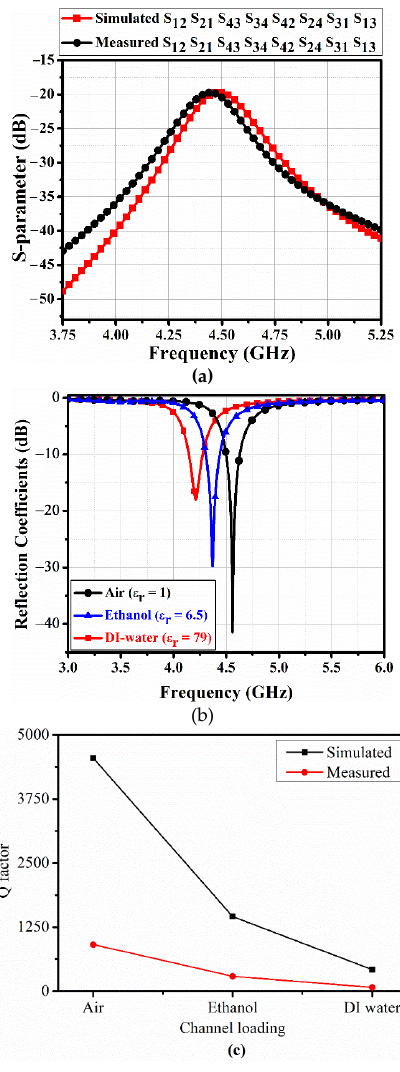
Figure 7. Fabricated 4-port quarter-mode substrate-integrated waveguide resonator ( a ) transmission S-parameters with empty microfluidic channels, ( b ) measured reflection coe ffi cients for port 1 (S 11 ), and ( c ) Simulated and measured Q factors (QFs) of the 4-port QMSIW resonator with air, ethanol, and deionized water (DI